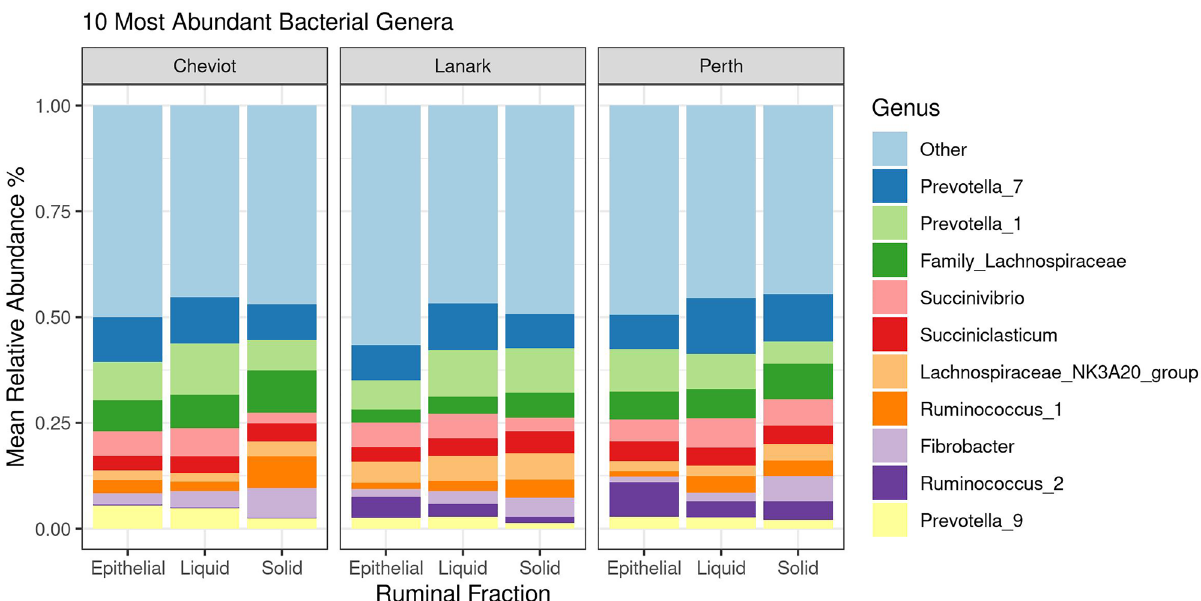
Figure 4. Stack barchart representing the mean relative abundance of the 10 most dominant bacterial genera across ruminal fractions (i.e. solid, liquid and epithelial) for Cheviot, Lanark and Perth breeds. Cheviot (solid n = 7, liquid n = 5, epithelial n = 5), Lanark (solid n = 7, liquid n = 5, epithelial n = 5), Perth (solid n = 7, liquid n = 5, epithelial n =